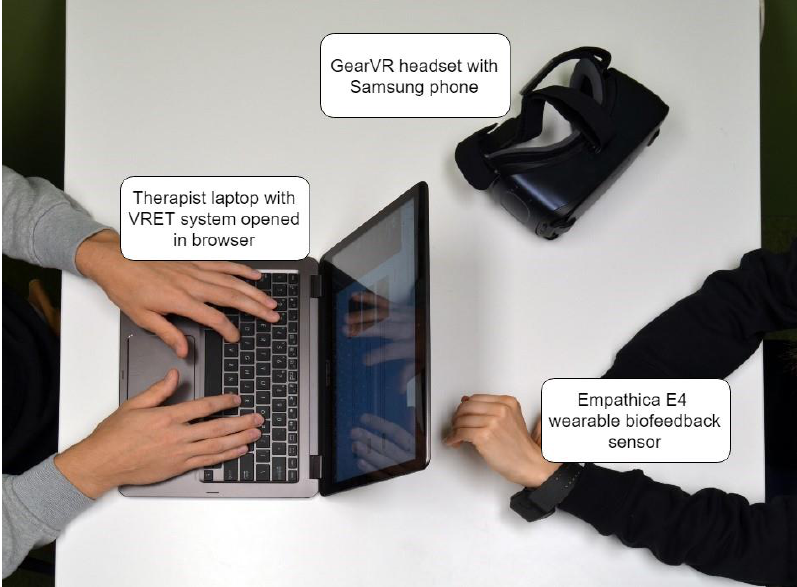
Figure 1. Key components of the virtual reality exposure therapy (VRET) system.